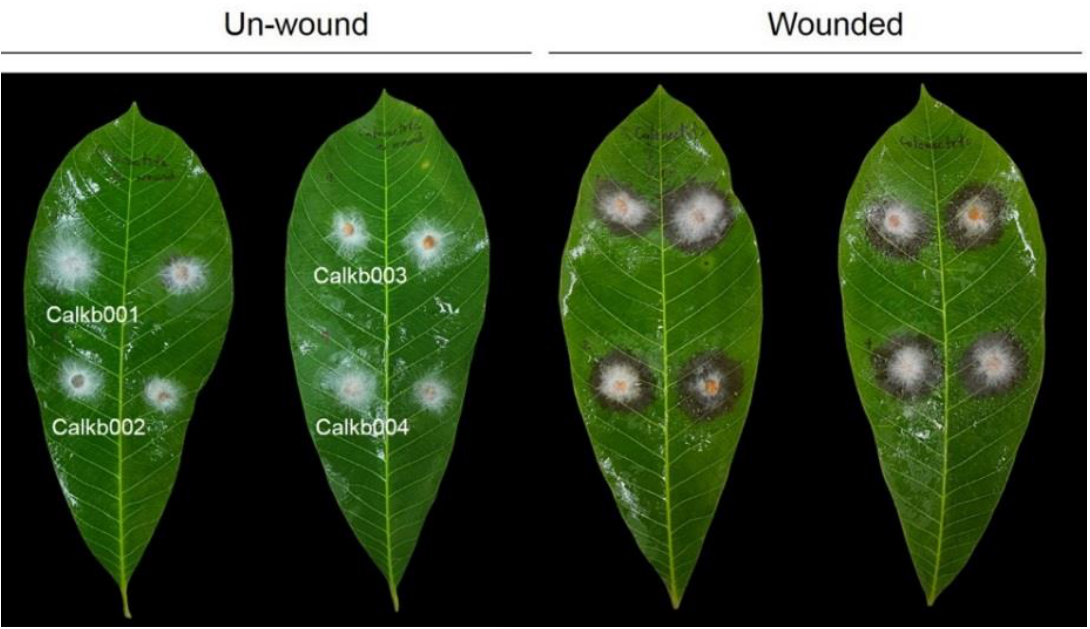
Figure 2. Pathogenicity test of leaf blight symptoms caused by the Calonectria foliicola isolates Calkb001, Calkb002, Calkb003, and Calkb004 on unwounded and wounded rubber tree leaf after 3 days post-inoculation.